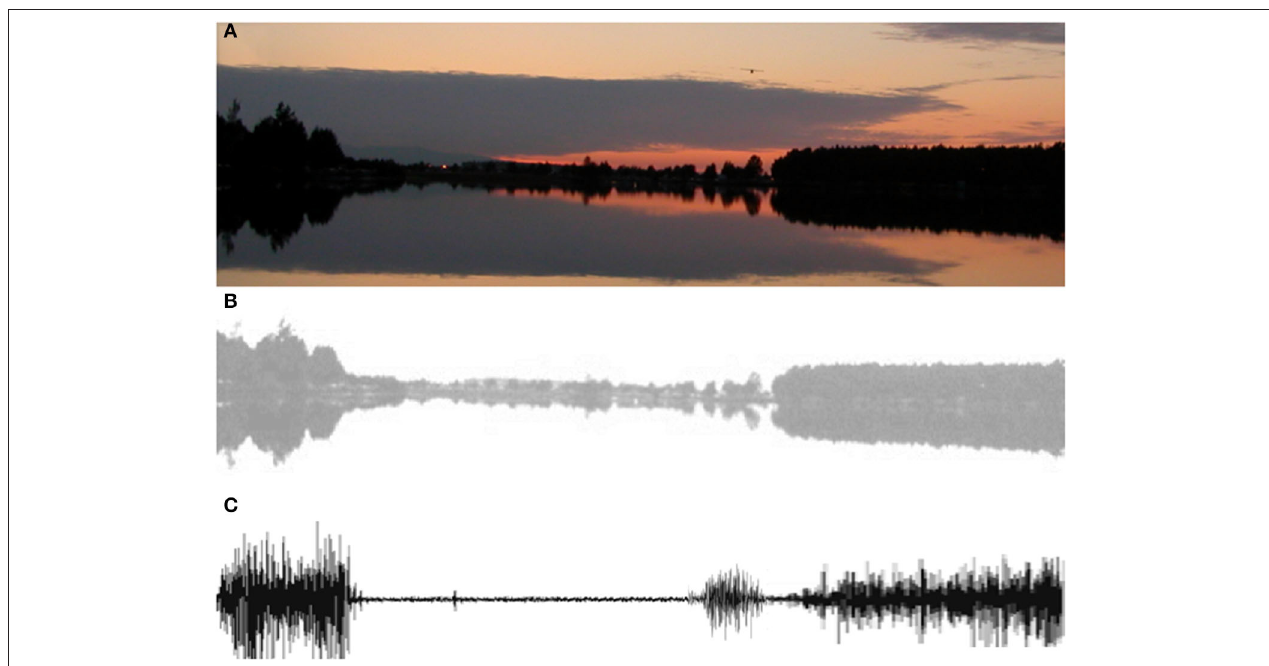
FIGURE 1 | The EMG forest or forest EMG. After adjusting the color (B) , the tree line, and its reflection over the dark water of the lake (unknown photographer) at sunset (A) produce an EMG-like signal (C) . Note that counting/identifying trees in the forest profile can be achieved by using filtering and different visual perspectives of the same scene—as done by the processing of photos obtained with multiple cameras in cutting-edge smart phones. Applied to the EMG signal for motor unit decomposition, a similar process is achieved using multiple comparisons of signals recorded by high-density electrode arrays (see text).